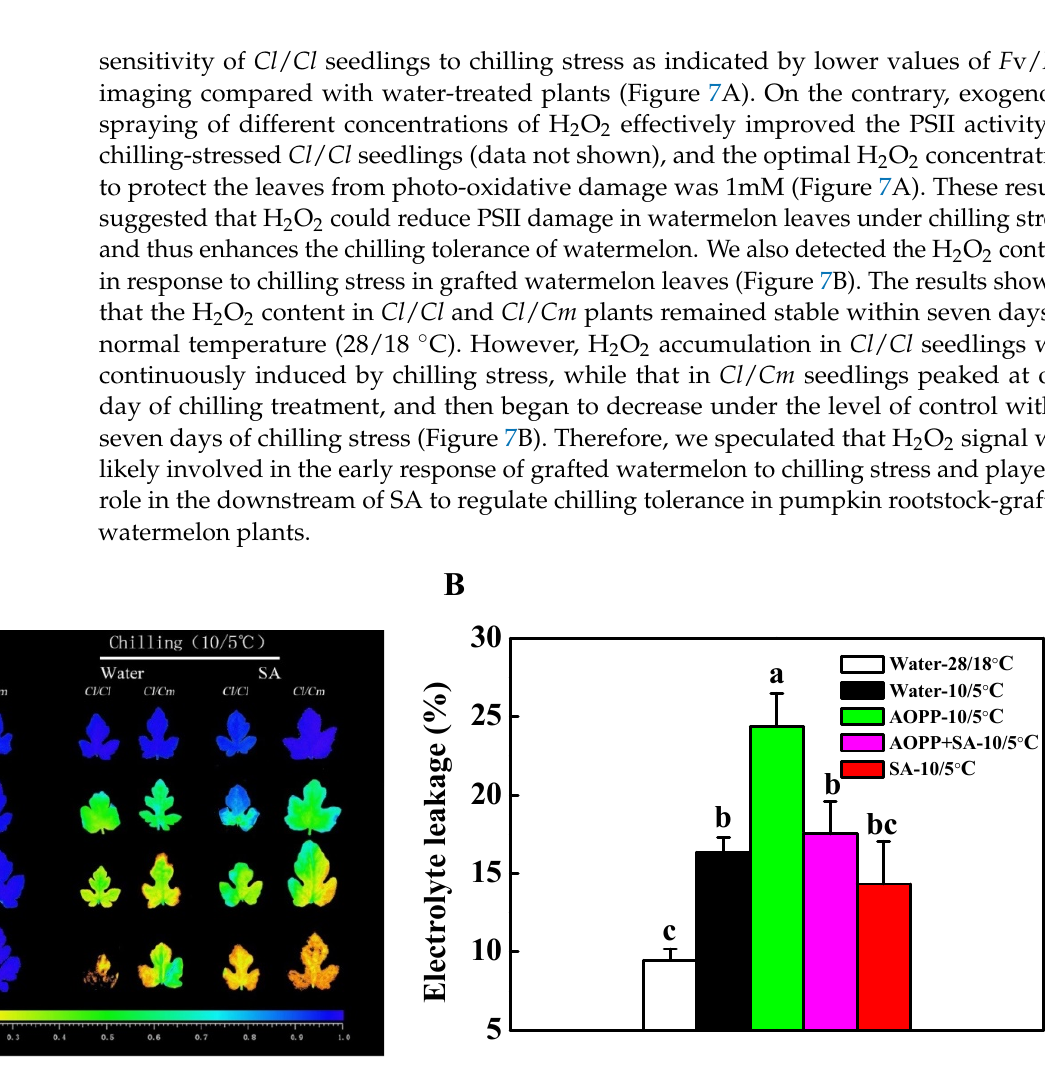
Figure 6. The role of SA-induced chilling tolerance in grafted watermelon plants. ( A ) Images of F v/ F m in water or SA-pretreated Cl / Cl and Cl / Cm plants under chilling stress. Leaf samples were collected at indicated times under control (28/18 ◦ C) and chilling (10/5 ◦ C) conditions. ( B ) Electrolyte leakage in the leaves of water, AOPP, AOPP+SA, and SA-pretreated Cl / Cl plants after 3 days of chilling stress. AOPP, L- α -aminooxy- β -phenyl propionic acid. Both SA and AOPP were treated at 50 µ M. The data are the means of four replicates with SEs. Different letters indicate significant differences according to Tukey’s test ( p < 0.05). Cl / Cl , self-grafted watermelon plants; Cl / Cm , pumpkin rootstock-grafted watermelon plants. The color gradient of the images in F v/ F m provided at the bottom of Figure 6A ranged from 0 (black) to 1.0 (purple).